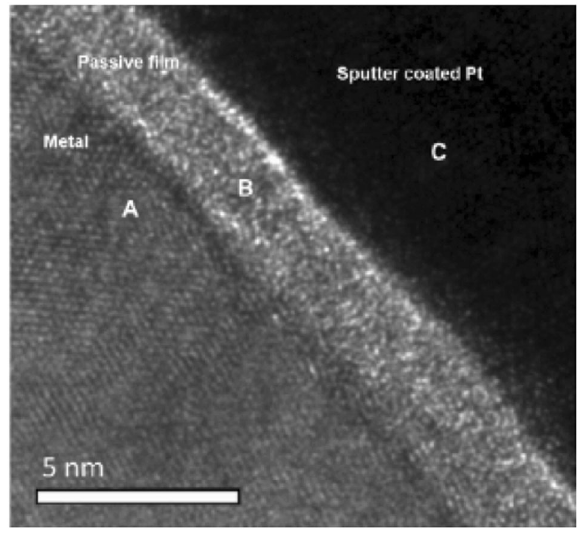
Fig. 4 TEM cross section of the passive fi lm on Fe-20Cr-10Ni formed in deaerated, 50°C, pH 8.5 borate buffer solution at 0.4 VSCE for 12 h. (reproduced with permission from ref. 195 , copyright Elsevier 2014)